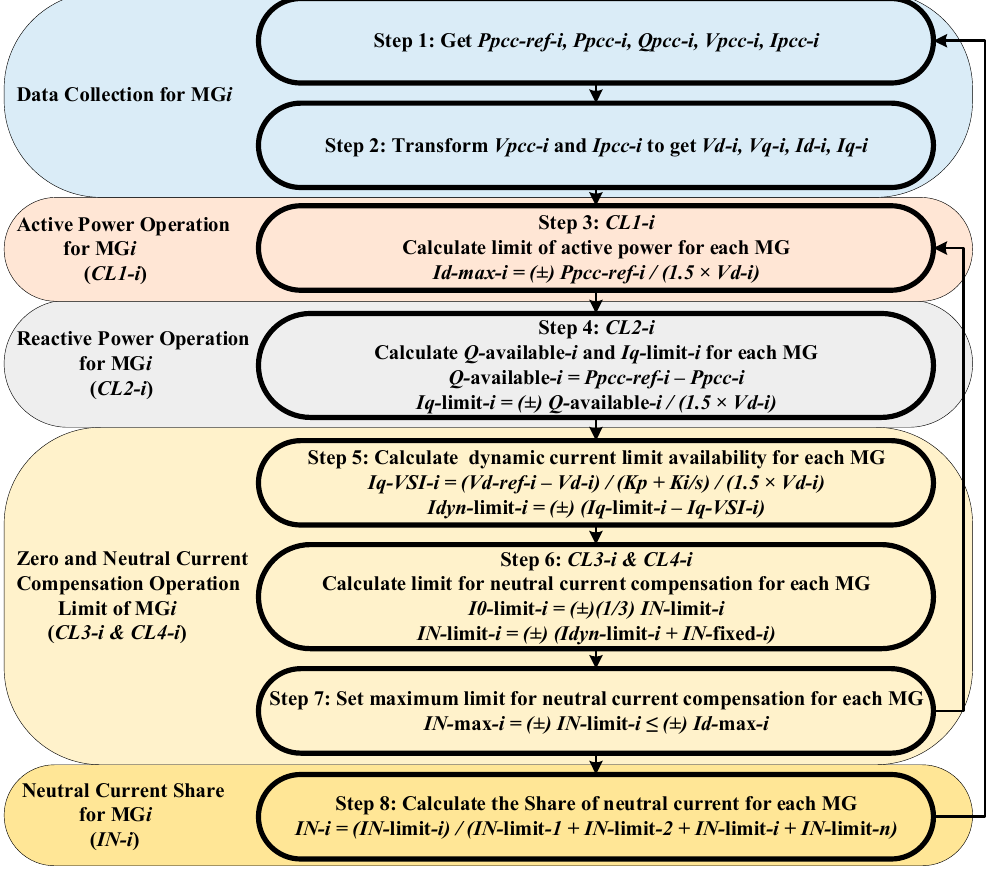
Figure 3. MMG dynamic Neutral Current Compensation (NCC) method.